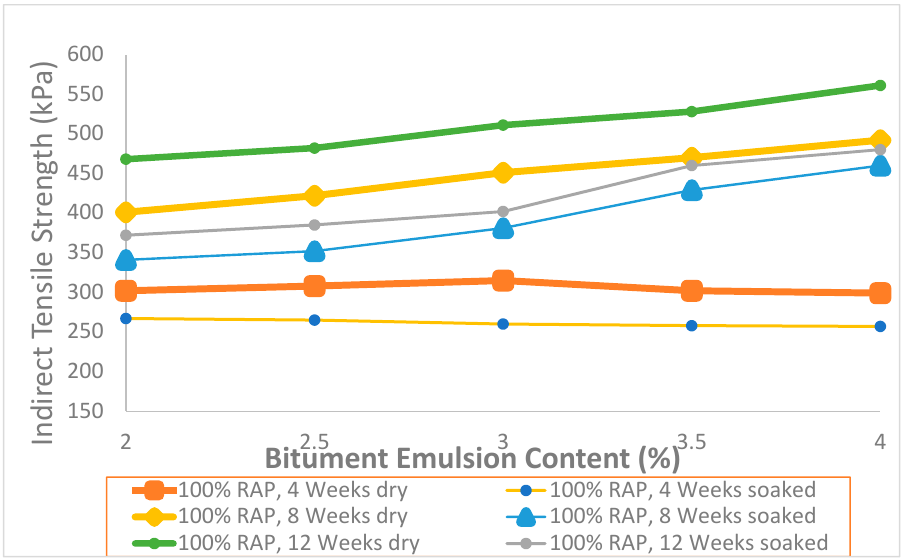
Figure 8. Results for indirect tensile strength test after different curing times in dry conditions.